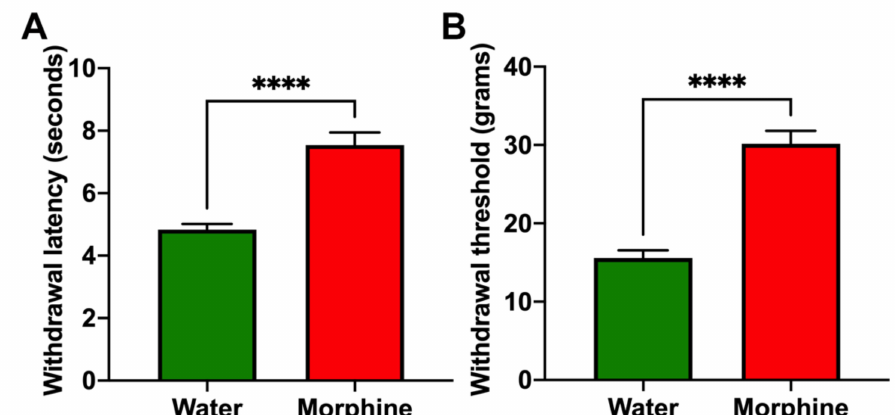
Figure 3. Voluntary morphine intake induces analgesia in Wistar rats. Hargreaves plantar test ( A ) and Von Frey test ( B ) showing the withdrawal latency (delayed response) to thermal stimulus and withdrawal threshold to mechanical stimulus, respectively, of rats that had voluntarily ingested a morphine solution for four weeks. Animals drinking only water were used as controls. Withdrawal latency and withdrawal threshold were measured during the first hour of light. Data are expressed as mean ± SEM. n = 8 in each experimental group. **** p < 0.0001, two-tailed Student t -test.